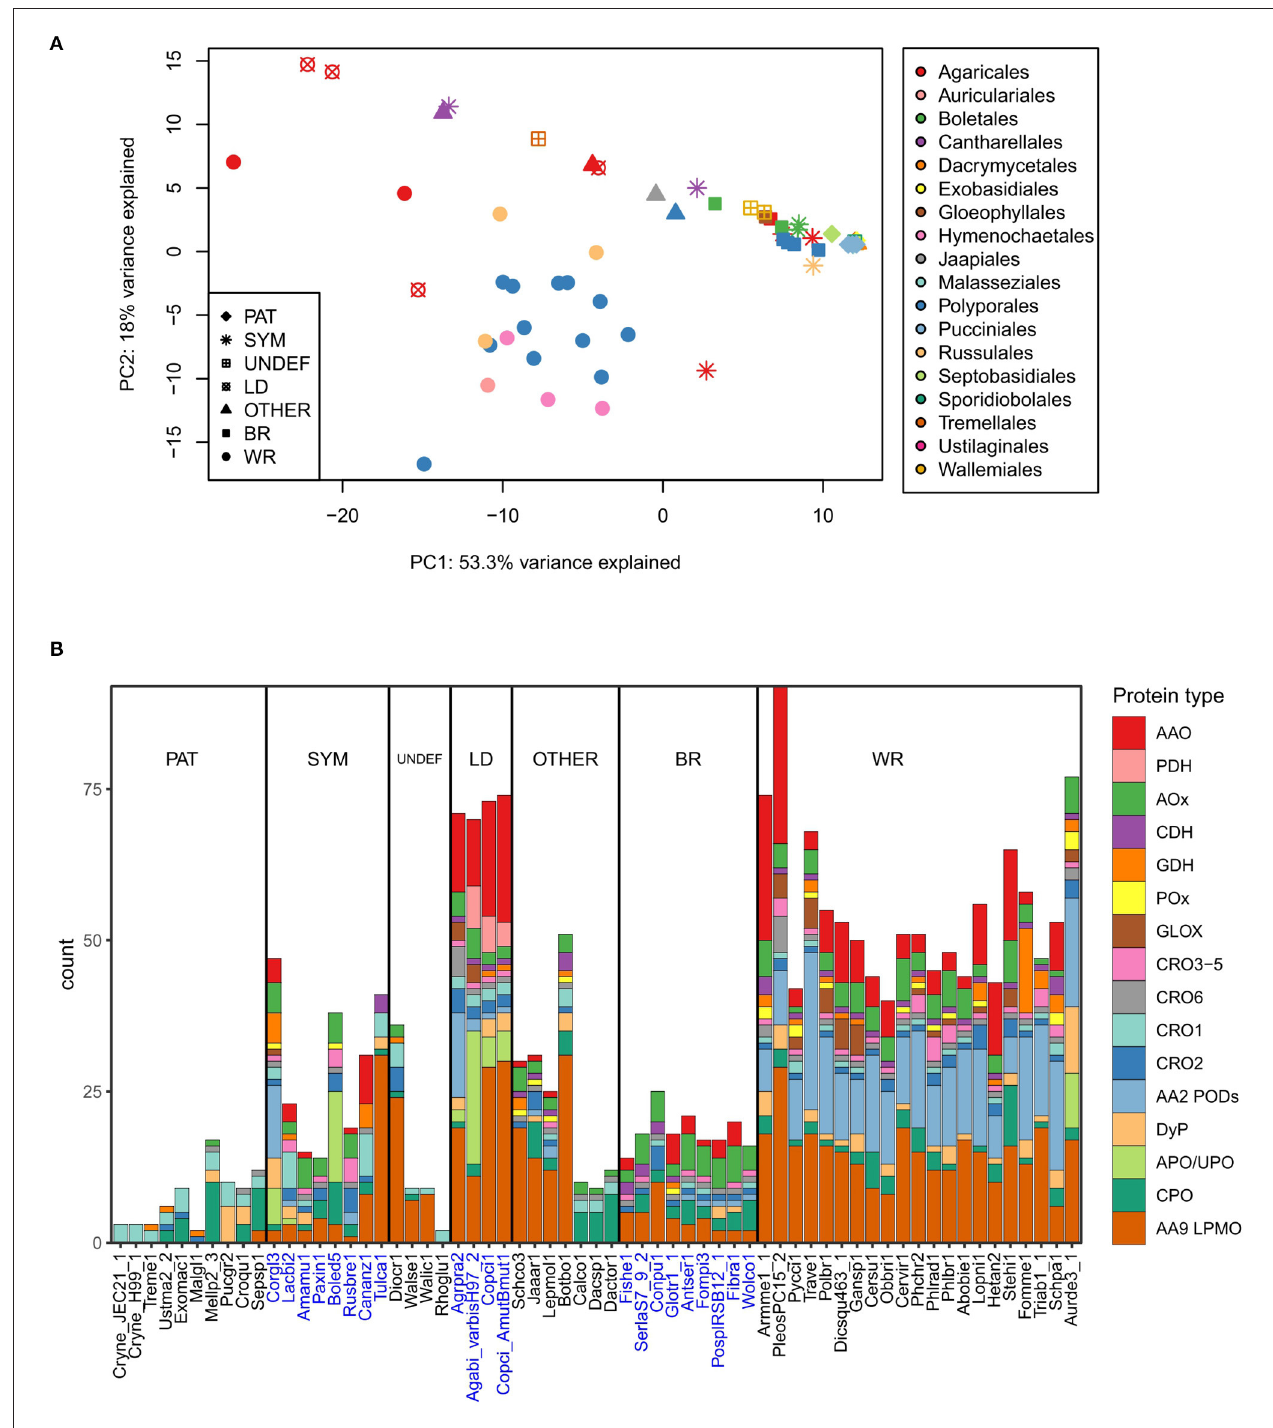
FIGURE 4 | Extracellular ROS generation and utilization-related enzymes in the Basidiomycota (A) in relation to their lifestyle and order-level taxonomy studied by principal component analysis on gene counts per each genome (top), and (B) distribution of genes in each species according to enzyme function and protein family (below). Ecological lifestyle groups: PAT, pathogenic; SYM, symbiotic mycorrhizal; UNDEF, saprobic undefined decomposition type; LD, litter-decomposing; OTHER, other type of wood decay; BR, brown rot; WR, white rot. Protein abbreviations are opened in the text.